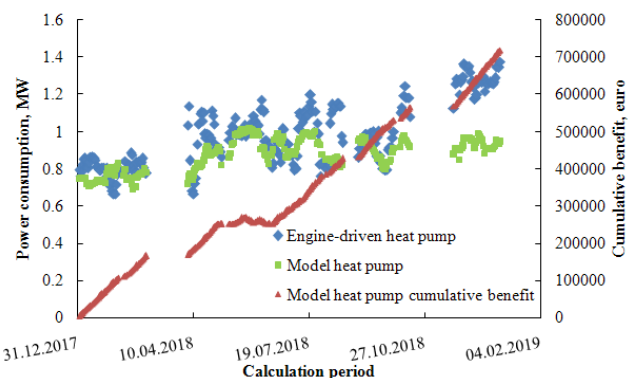
Figure 12. Cumulative benefit and the underlying net power production surplus over one year calculation period for Case B—combustion engine-driven heat pump installation.